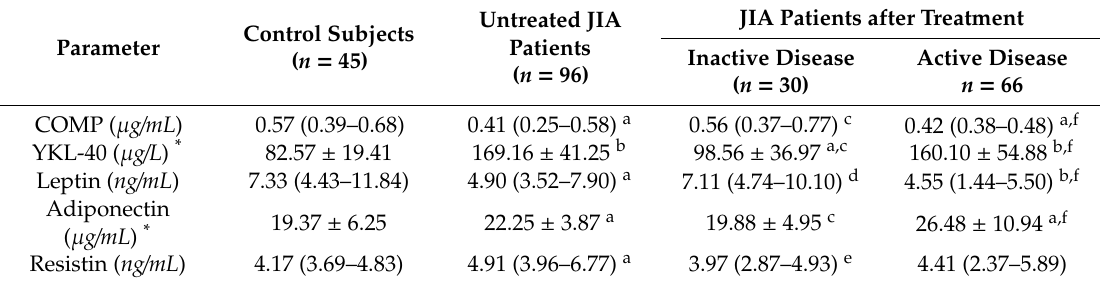
Table 1. The distribution pattern of serum cartilage oligomeric matrix protein (COMP), human cartilage glycoprotein-39 (YKL-40), and adipocytokines (leptin, adiponectin, and resistin) in healthy controls and juvenile idiopathic arthritis (JIA)